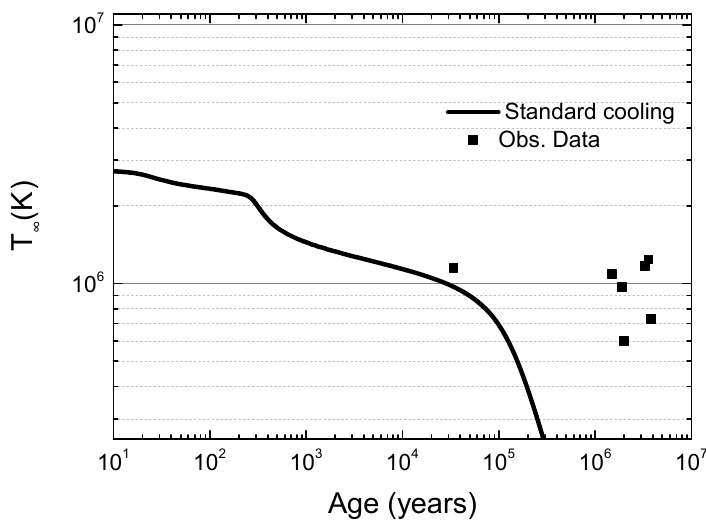
Figure 3. Temperature evolution of a 1.5 M (cid:12) neutron star. The squares represent the observed temperature of the XDINS at their respective spin-down